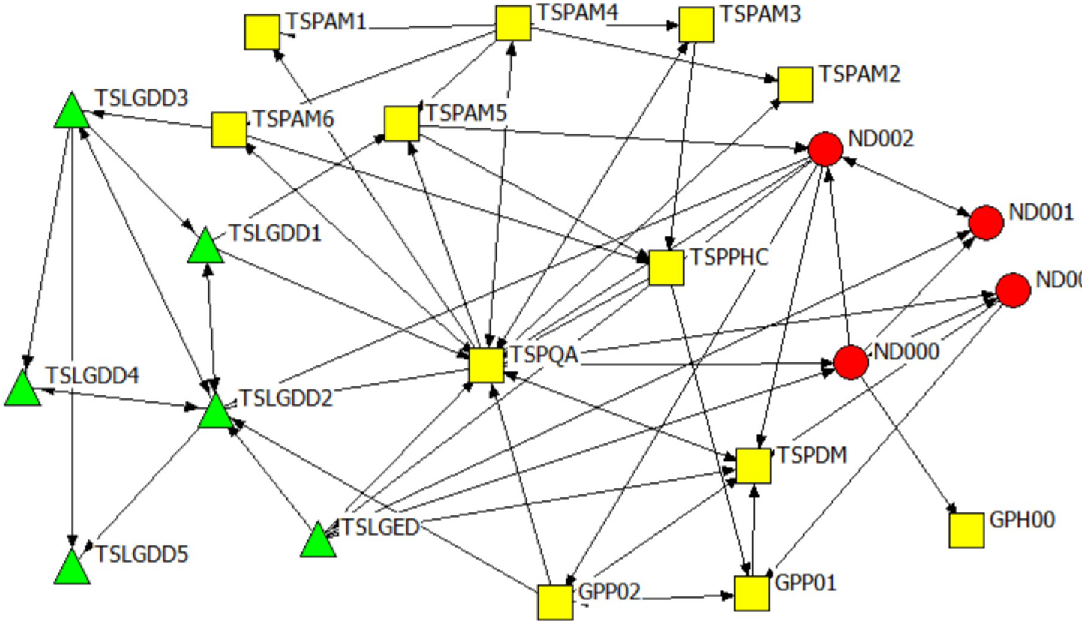
Fig 4. Gauteng province network: Providing support. Colour and Shape of nodes: red circle = National, yellow square = Provincial, and green triangle = Local Government. Nodes labels: ND = A label starting with TSP or GP refers to a provincial actor, TSLG = A label starting with TSLG refer to a local government